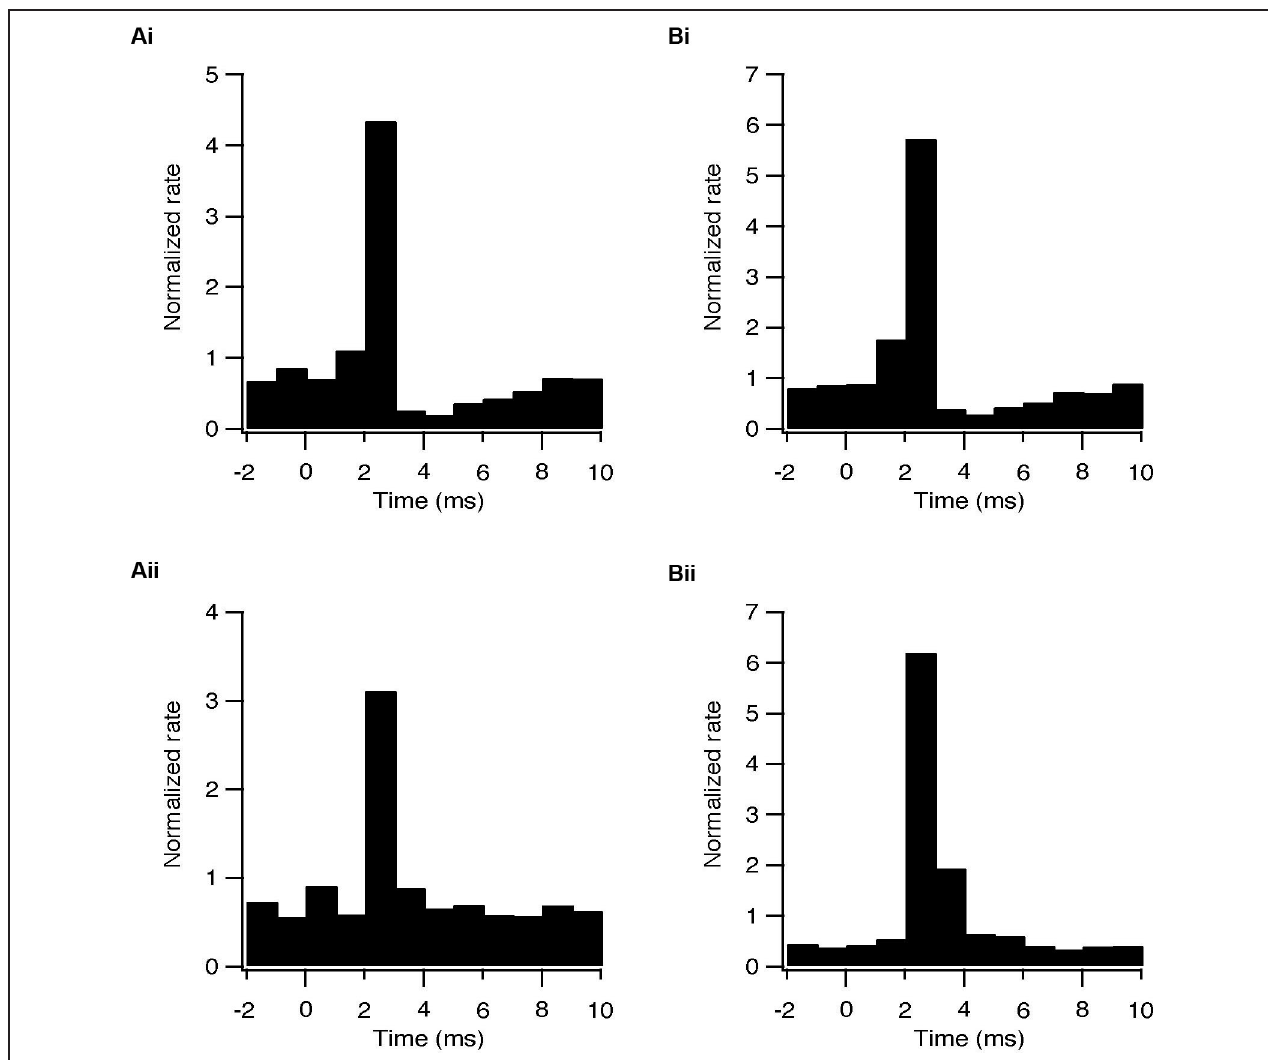
FIGURE 5 | Activation of GABAergic synapses during STN stimulation at 10 and 100 Hz. (A) Population PSTH of the response to each pulse of subthalamic (i, n = 5) and pallidal (ii, n = 7) neurons under control conditions.